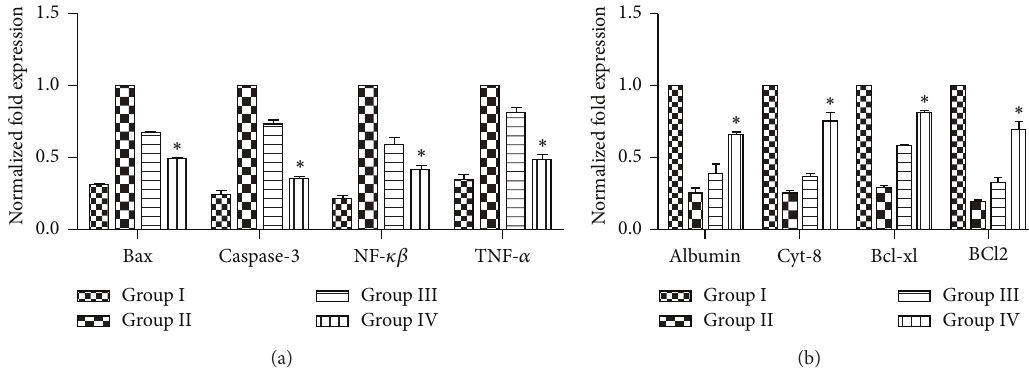
Figure 11: (a) Gene expression profiling after 3 weeks of transplantation: real time PCR analysis for apoptotic ( Bax, caspase-3, NF- 𝜅𝛽 , and TNF- 𝛼 ) genes between the experimental groups. The ∗ 𝑃 < 0.05 versus Group III and Group II. (b) Gene expression profiling after 3 weeks of transplantation: real time PCR analysis for hepatic ( Albumin, Cytokeratin 8 ) and antiapoptotic ( Bcl-xl, Bcl groups. The ∗ 𝑃 < 0.05 versus Group III and Group